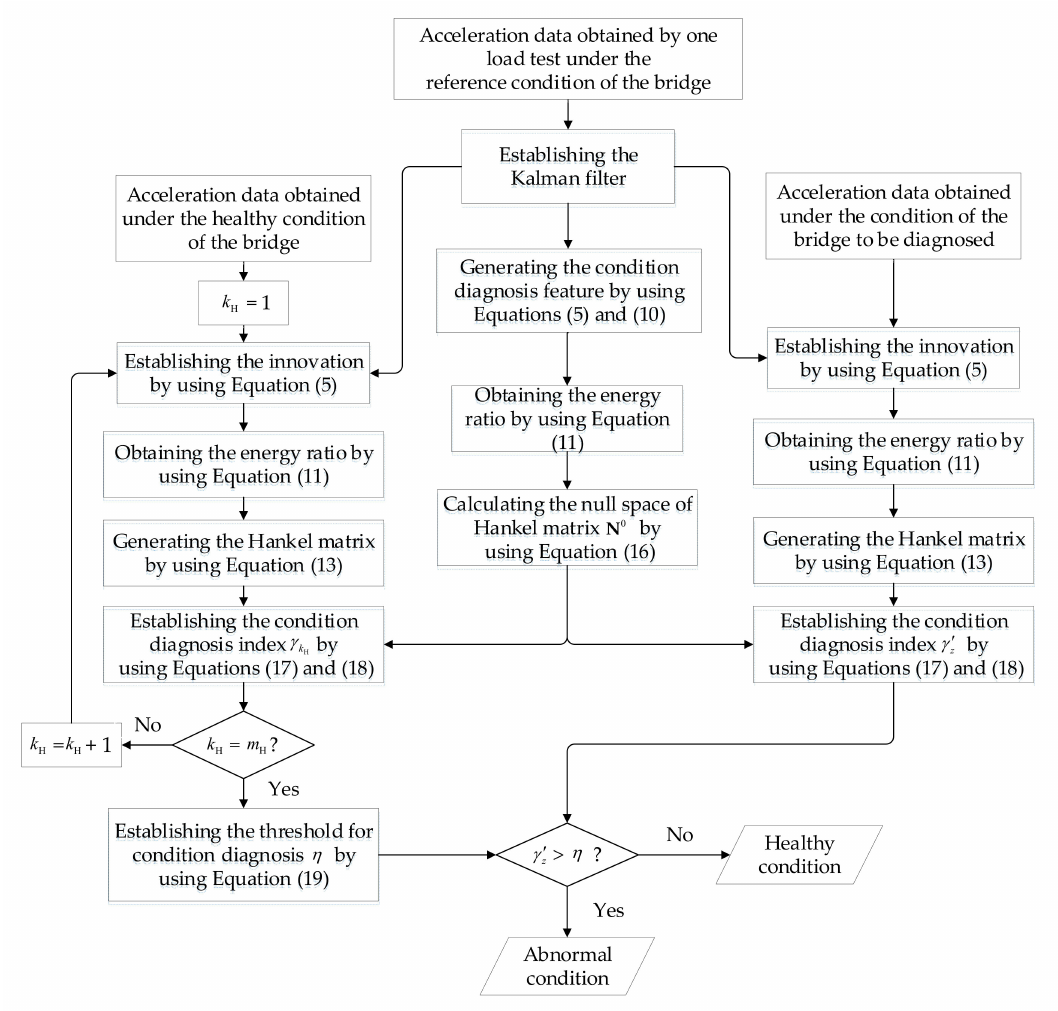
Figure 1. Flowchart of the proposed Kalman filter-based method for diagnosing the condition of